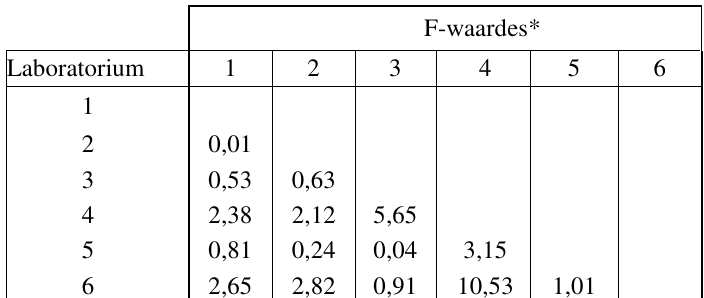
BEDUIDENDHEID VAN VERSKILLE TUSSEN